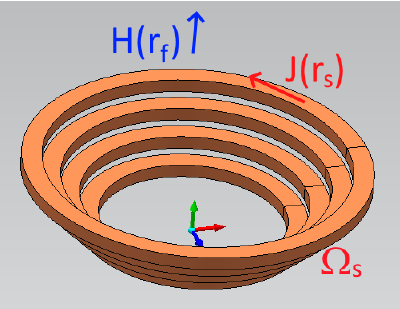
Figure 1. A schematic layout of the source domain Ωs and of the (simulated) field sensors (an ex- ample being represented by the blue vector H ( r f )). being represented by the blue vector H ( r f